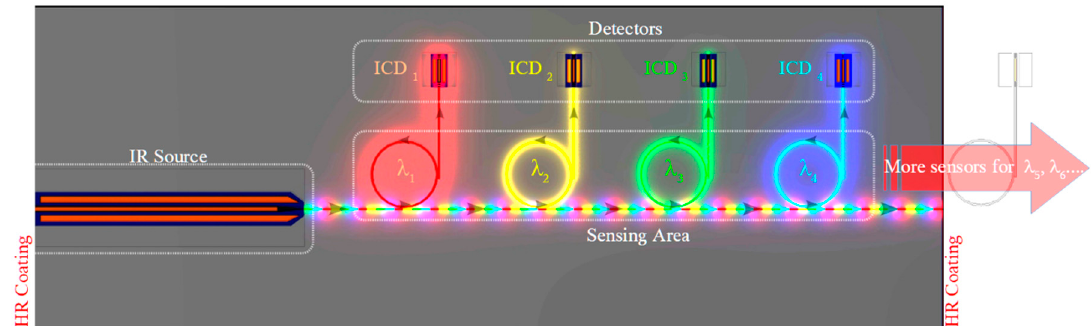
Figure 11. Schematic of an on-chip chemical sensor in which an ICL source emits into to a passive bus waveguide for coupling to a series of ring resonators [37]. Each ring extracts a different comb of resonance wavelengths. The individual rings then evanescently couple to ICDs that quantify the spectral dependence of the absorption.